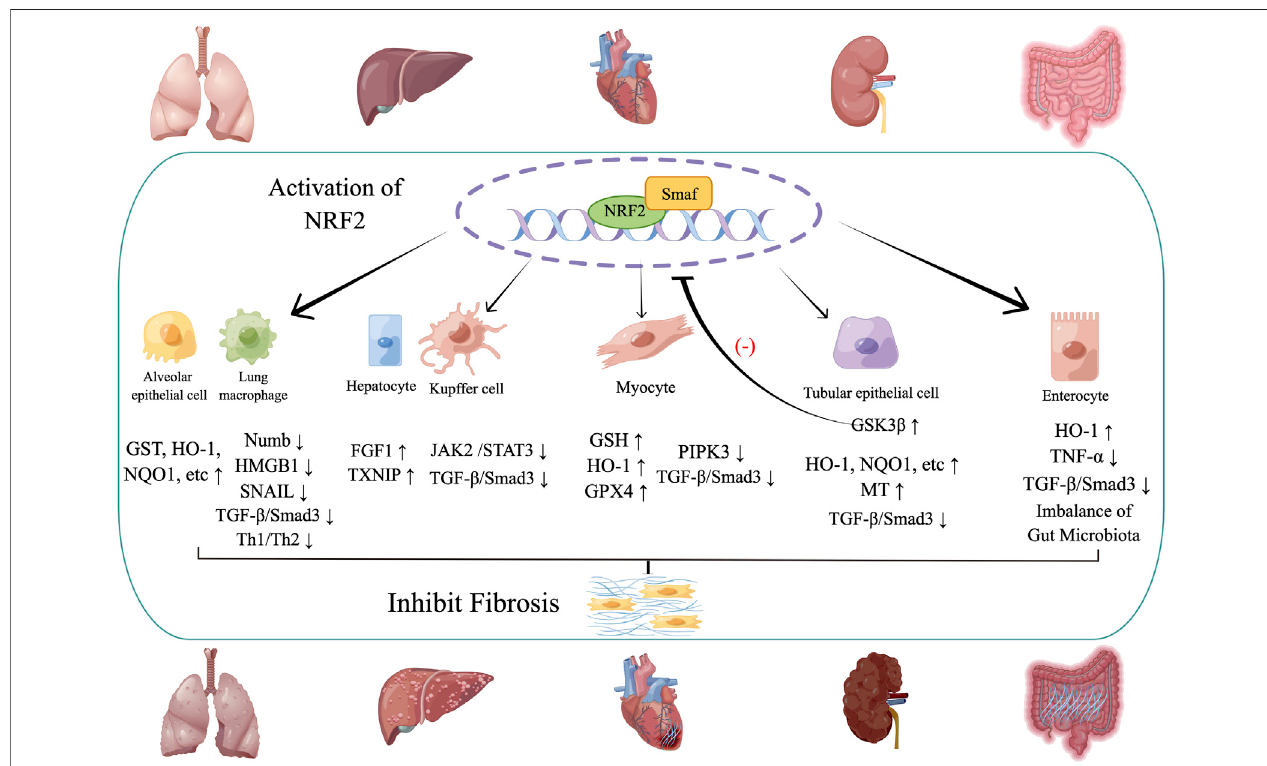
FIGURE 2 | The activation of NRF2 in different